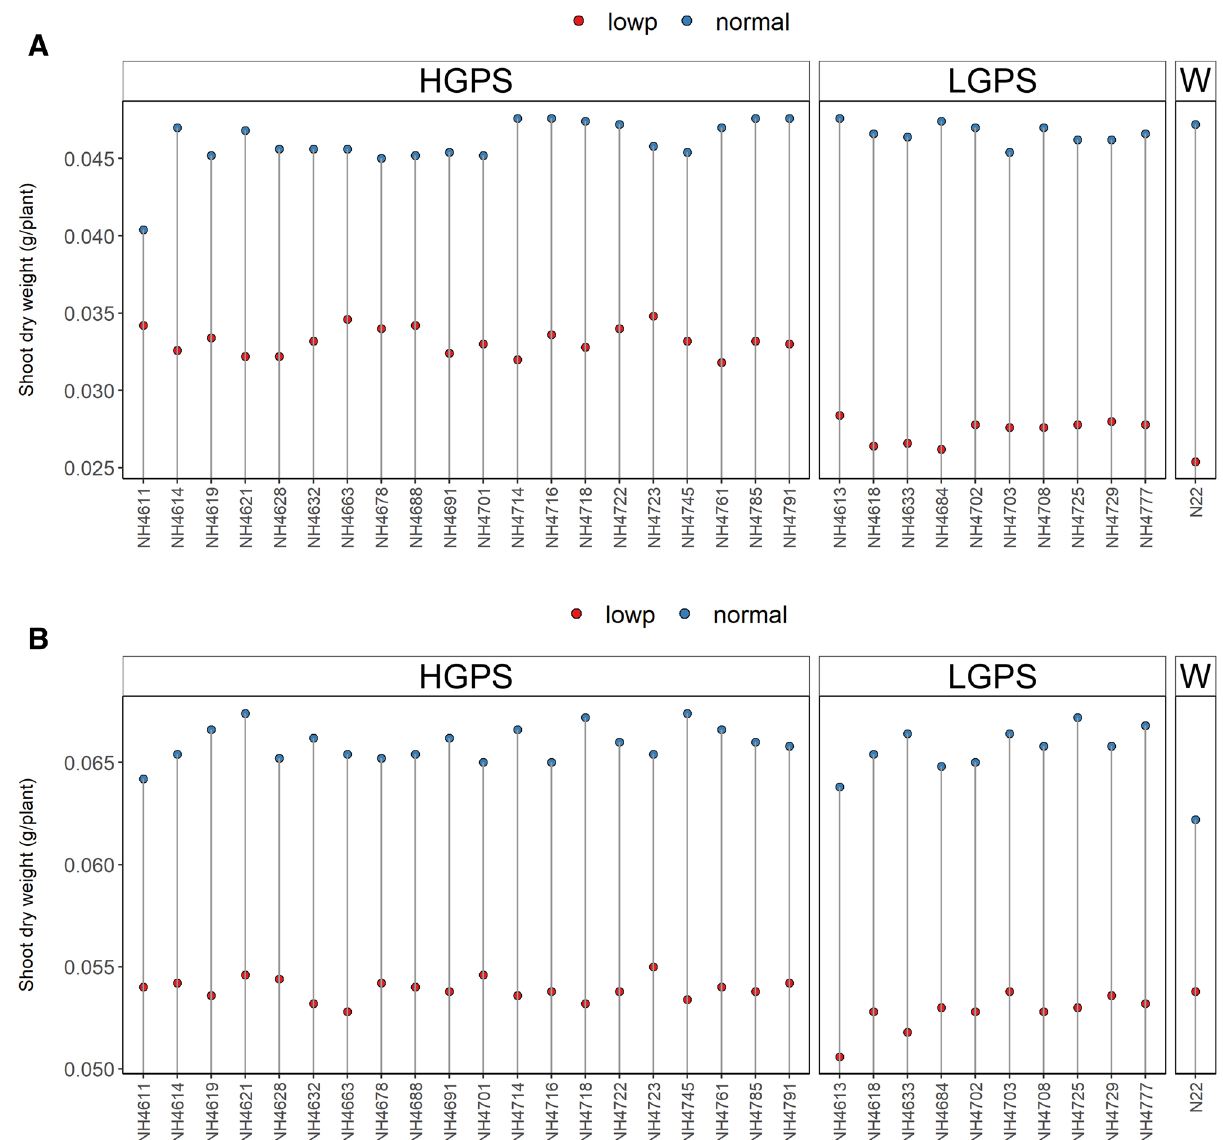
Figure 5. Shoot dry weight of seedlings obtained from germination of seeds harvested from low P (shown as red dots) and normal P (shown as blue dots) fields. Wild type N22 (W), high grain P mutant seedlings (HGPS), and low grain P mutant seedlings (LGPS) were grown under normal P condition. ( A ) Shoot dry weight at 12 days of germination. ( B ) Shoot dry weight at 24 days of germination. The values represent the mean of 20